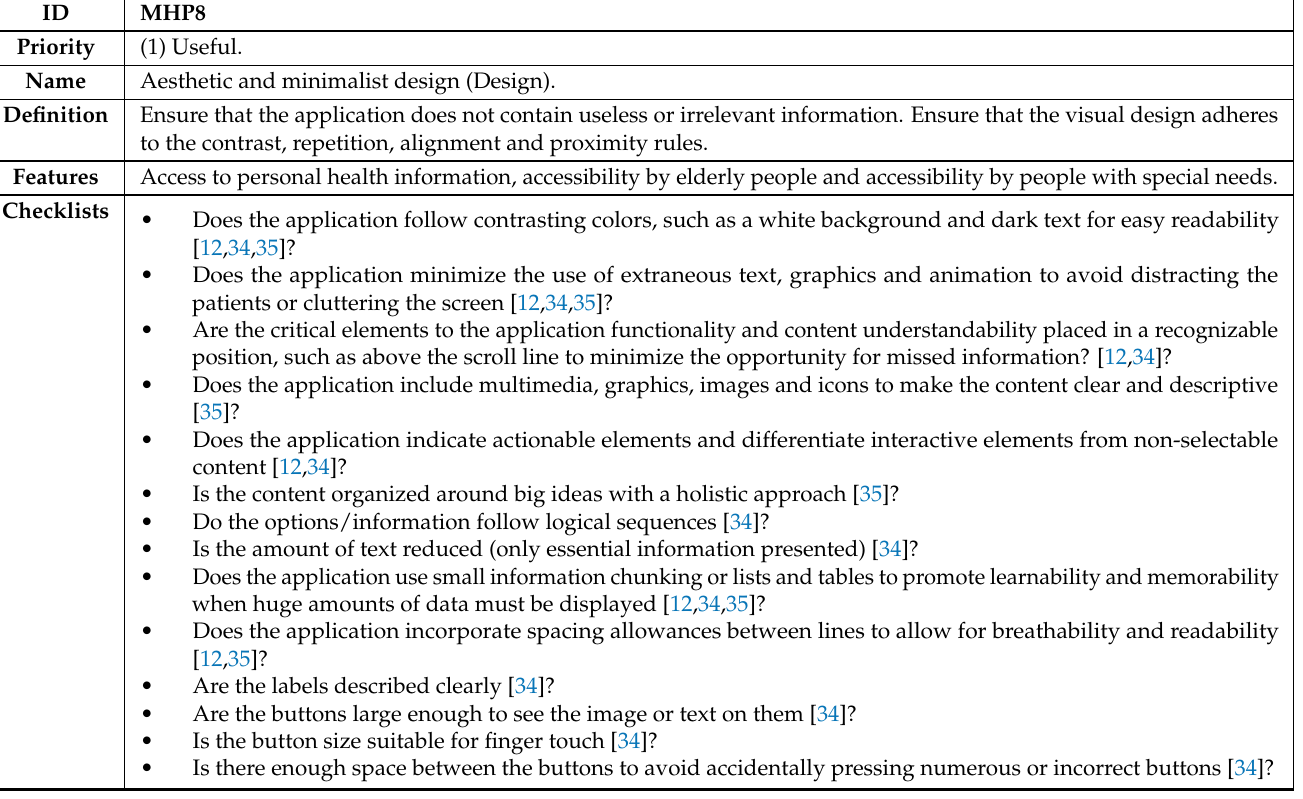
Table A8. Descriptive details of the eighth guideline.